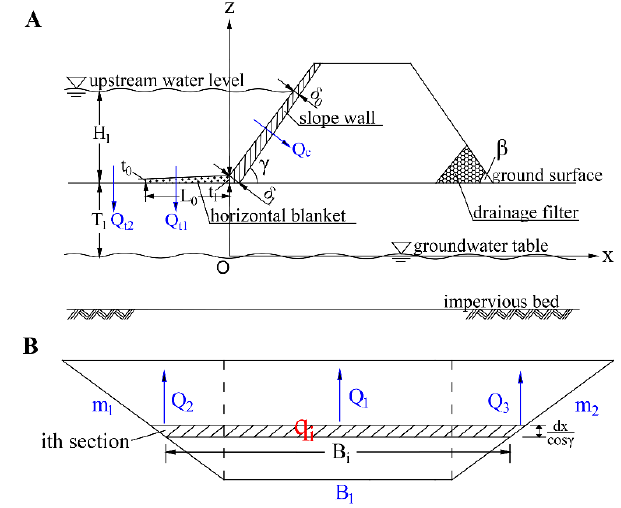
Figure 1. Layouts generalization of the slope-wall dam with a horizontal blanket (low groundwater level): ( a ) a typical cross section of the dam; ( b ) front view of the simplified slope wall.